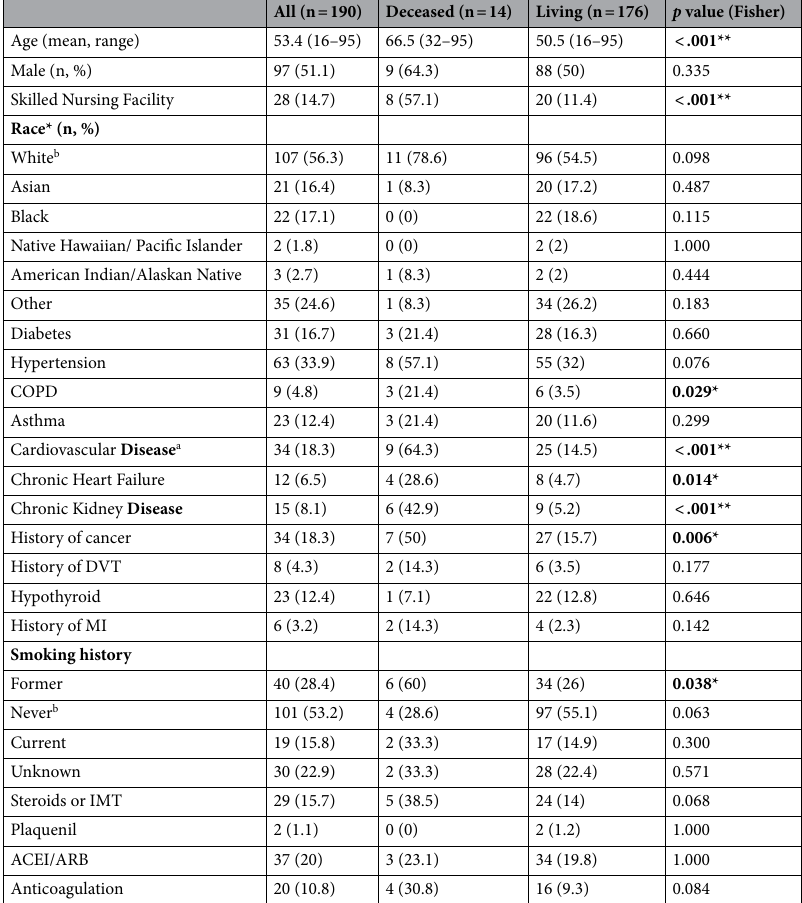
Table 2. Baseline demographics and medical histories of patients stratified by mortality. a 2 sequences were excluded as they were not characteristic of either clade. b Reference value. c Cardiovascular disease defined as history of MI, CVD/stroke, CHF, valvular diseases (s/p CABG). All diseases were defined using ICD-9 and ICD-10 codes. DVT Deep Venous Thrombosis, COPD chronic obstructive pulmonary disease, MI myocardial infarction, ACEI angiotensin-converting enzyme inhibitors, ARB angiotensin receptor blocker, IMT immunomodulatory